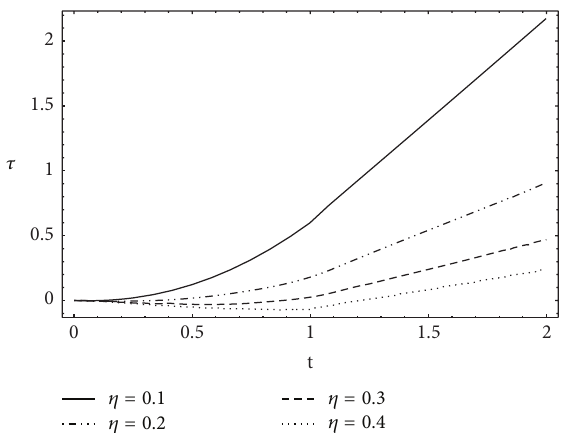
Figure 12: Variations of Nusselt number Nu along 𝑡 for different values of Pr corresponding to ramped temperature of the